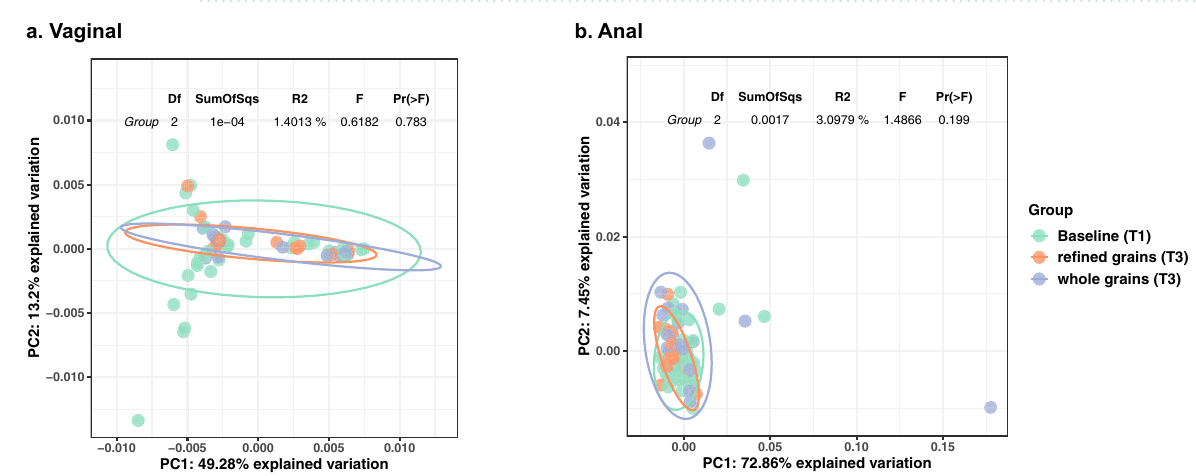
Figure 2. LEfSe cladogram of differing taxa. Significantly enriched taxa colored in purple for refined grains diet, green for whole grains diet. g_ for genus level, f_ for family level, o_ for order level, c_ for class level, and p_ for phylum level. ( a ) Vaginal overrepresented taxa in each group. ( b ) Anal overrepresented taxa in each group.